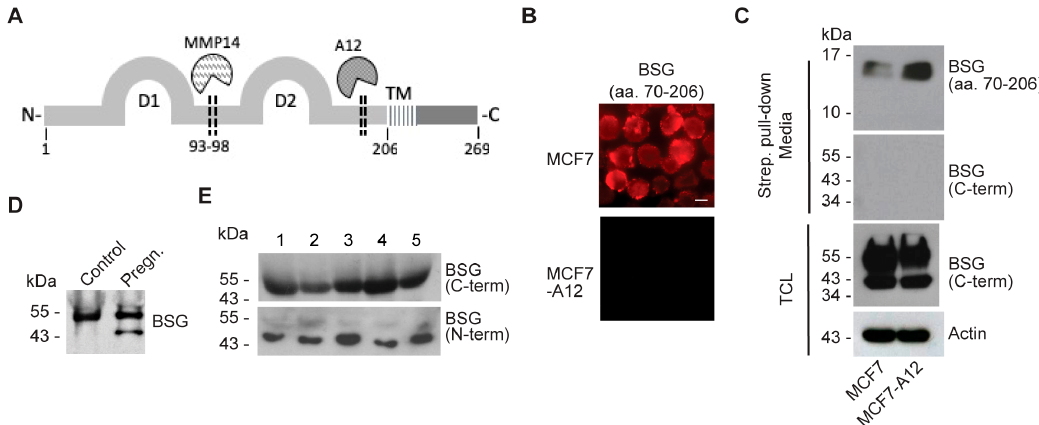
Figure 4. ADAM12 sheds endogenous BSG. ( A ) Schematic of the BSG structure, showing the two immunoglobulin domains (D1 and D2), the identified MMP14 and putative ADAM12 (A12) cleavage sites, and the transmembrane domain (TM). ( B ) Cytospin of wildtype or A12 expressing MCF7 cells were immuno-stained with the antibody PA5-29787, recognizing region aa. 70–206 of BSG. Scale bar = 8 µ m. ( C ) Wildtype or A12 expressing MCF7 cells were surface biotinylated and incubated overnight in serum free media. Biotinylated cell surface proteins were pulled down with streptavidin–agarose from conditioned cell media or total cell lysates (TCL) and detected by Western blot, using antibodies against aa. 70–206 (PA5-29787) or the C-terminus of BSG. Actin was used as a loading control. ( D ) Western blot of BSG in serum from pregnant (pregn.) or non-pregnant (control) women. ( E ) Western blot of BSG in serum from five bladder cancer patients stained with antibodies recognizing either the C- or the N-terminus of BSG.